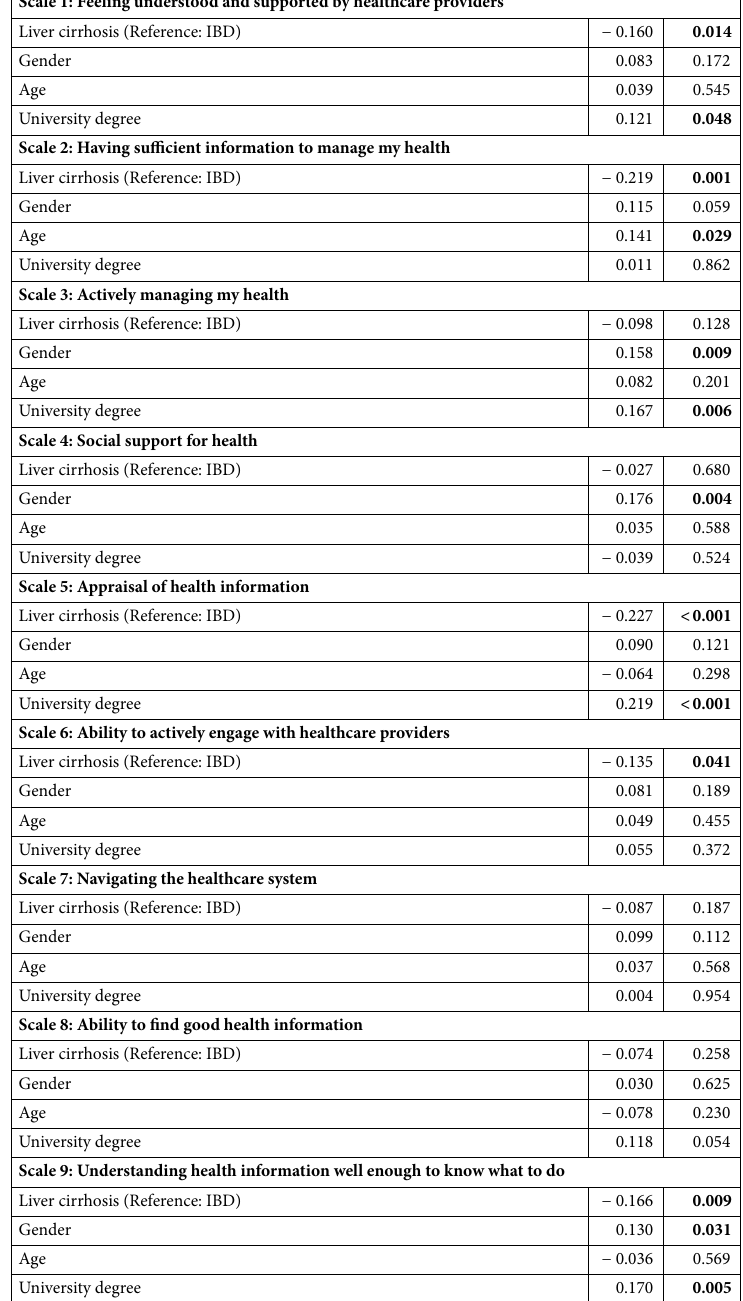
Table 3. Multivariable linear regression analyses of each subscale of the HLQ comparing patients with liver cirrhosis and inflammatory bowel disease (IBD). Significant values are in [bold]. IBD was coded as 1 and liver cirrhosis was coded as 2. Gender: men were coded as 1 and women as 2. University degree was coded as 1 and no university degree was coded as